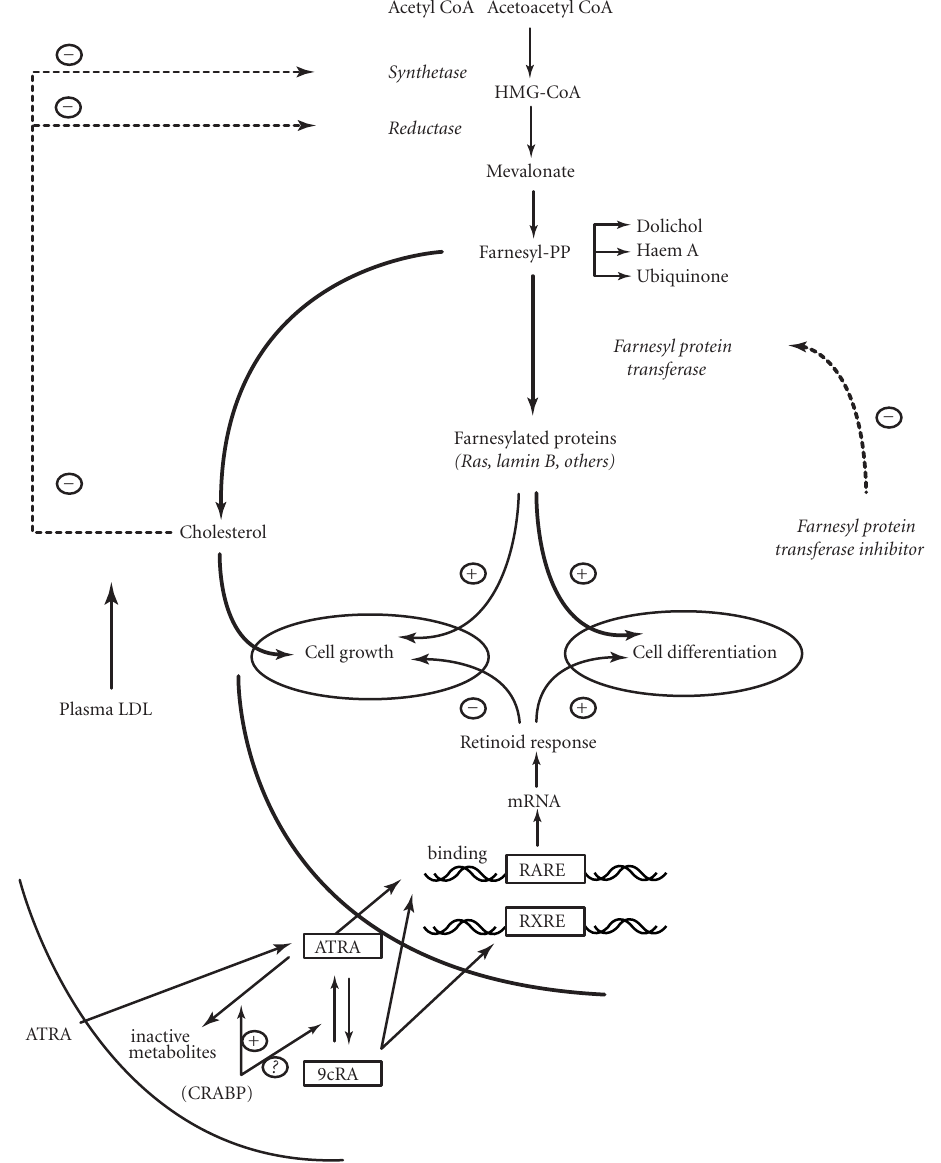
Figure 6: Interaction between mevalonate pathway and retinoic acid-induced differentiation.